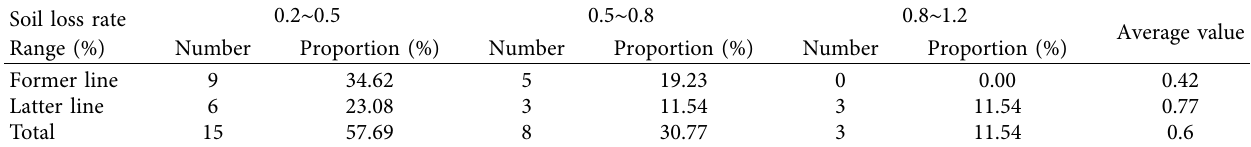
Table 2: Distribution of loss rate in silt soil region in Hangzhou Metro Line 6.